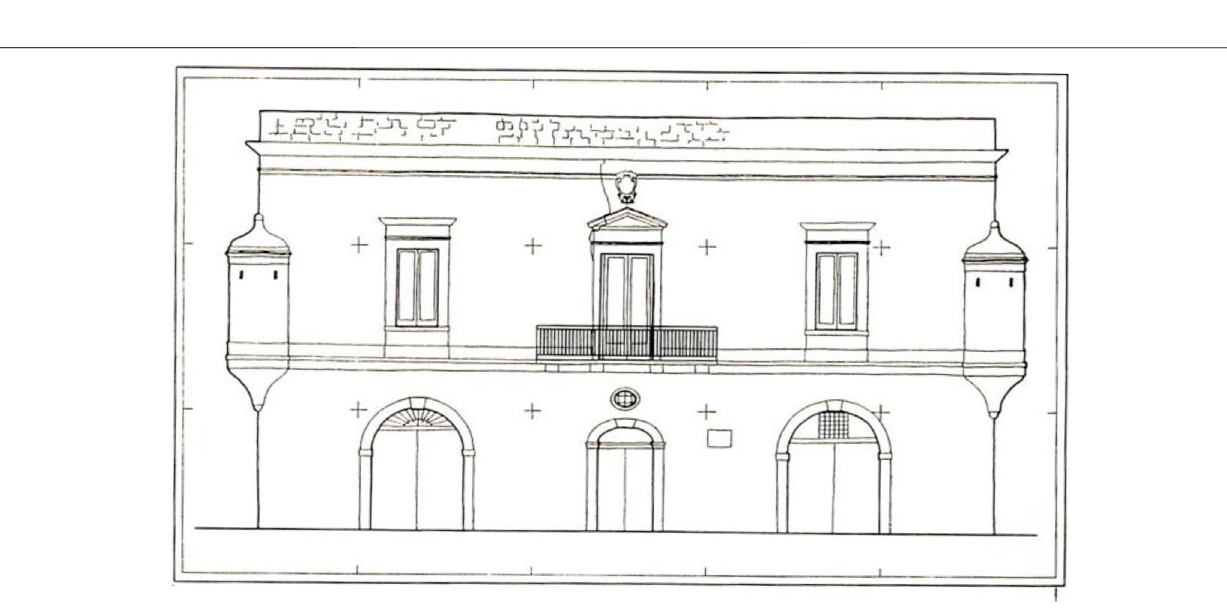
FIGURE5| FaçadeofMasseria “ LaMarchesa ” locatedinsouthernItaly(Basilicataregion),surveyedthroughterrestrialphotogrammetrictechniques(Maneraetal., 1990).